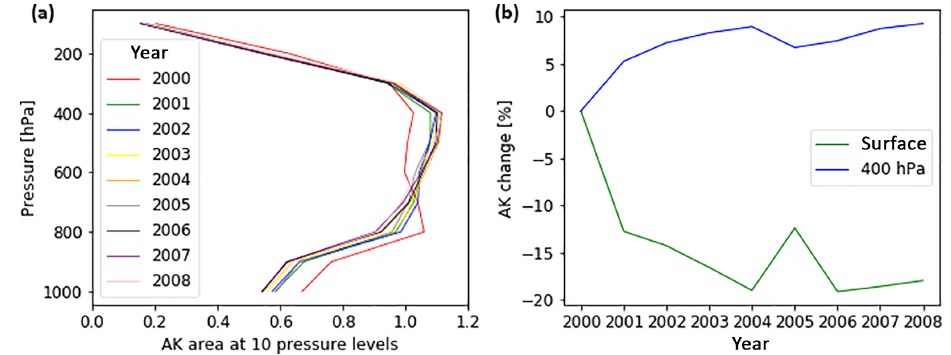
Figure 7. Yearly averaged AK area (Rodgers, 2000) values over the 400km 2 area around Madrid for the years 2000 to 2008, March– December (except for June and July to minimize biases from uneven sampling), for the V6 multispectral product: (a) vertical profiles from the surface to the top level for corresponding main diagonal value of the AK , (b) change in average AK compared to the year 2000 for the surface level (blue) and 400hPa level (green).